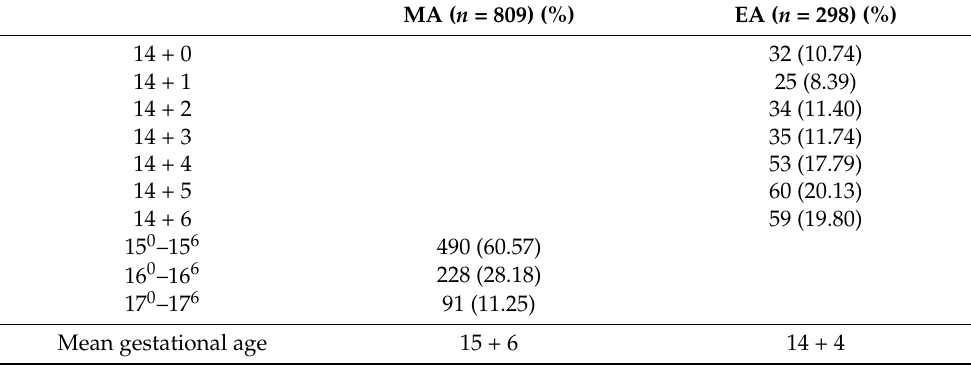
Table 1. Gestational age (weeks + days).